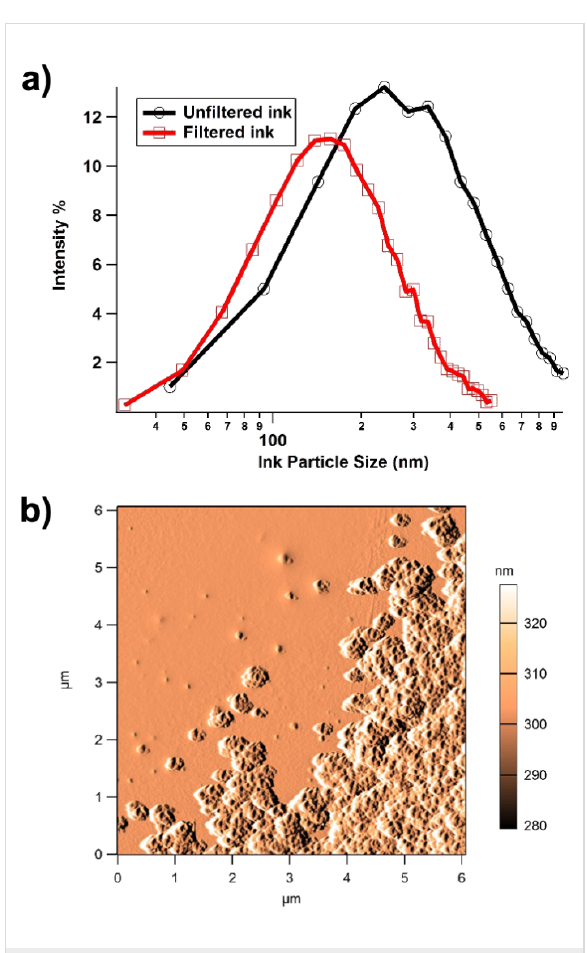
Figure 1: (a) Particle size distribution of filtered vs unfiltered commer- cially available tattoo ink, showing data ranging between 30 to 600 nm (filtered) and 40 to 970 nm (unfiltered). (b) Amplitude image of tattoo ink particles showing single and agglomerated particles adhered to a glass